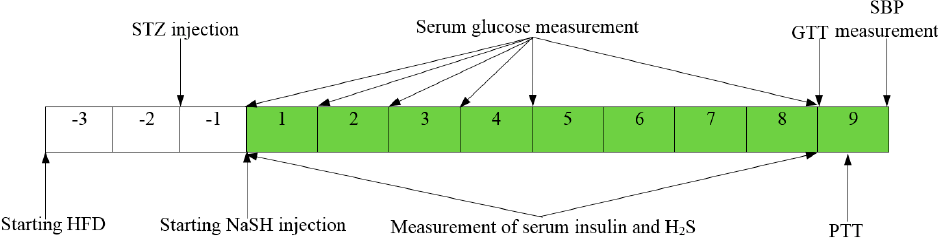
Figure 9. Experimental design; the dark squares indicate weeks of NaSH injection. HFD, high-fat diet; STZ, streptozotocin; GTT, glucose tolerance test; PTT, pyruvate tolerance test; NaSH, sodium hydrosulfide; SBP, systolic blood pressure.